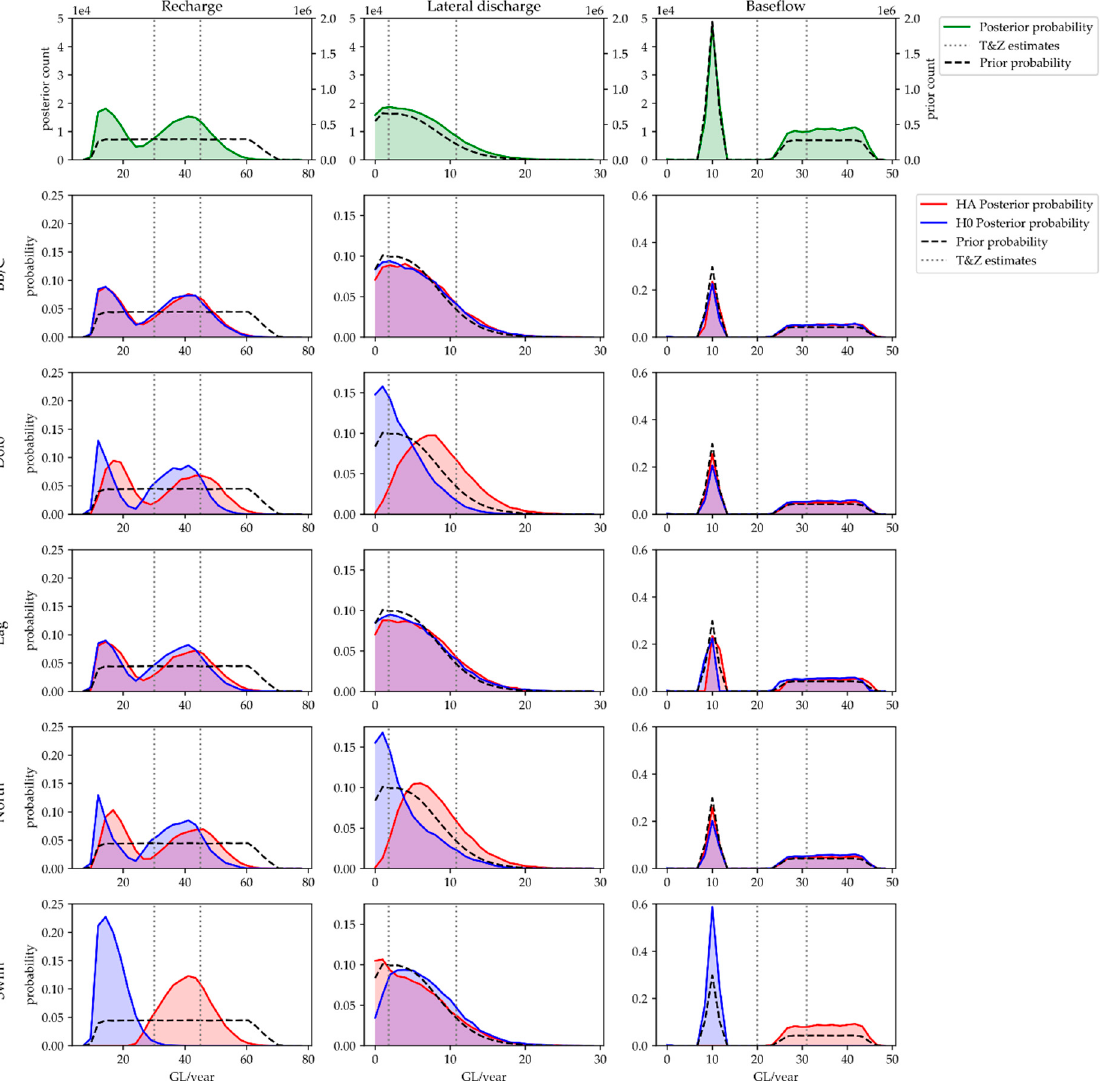
Figure 5. Prior and posterior probability of water balance components’ recharge, lateral discharge and baseflow in Giga Liters / year (GL / year). Top row shows the probabilities for all conceptual models, while in the remaining rows the posterior probabilities are subdivided into the null and the alternative hypothesis regarding the row. Individual estimates of the three water balance components from a previous study [50] are shown as vertical lines. Note the difference in scale for the prior and posterior probabilities.